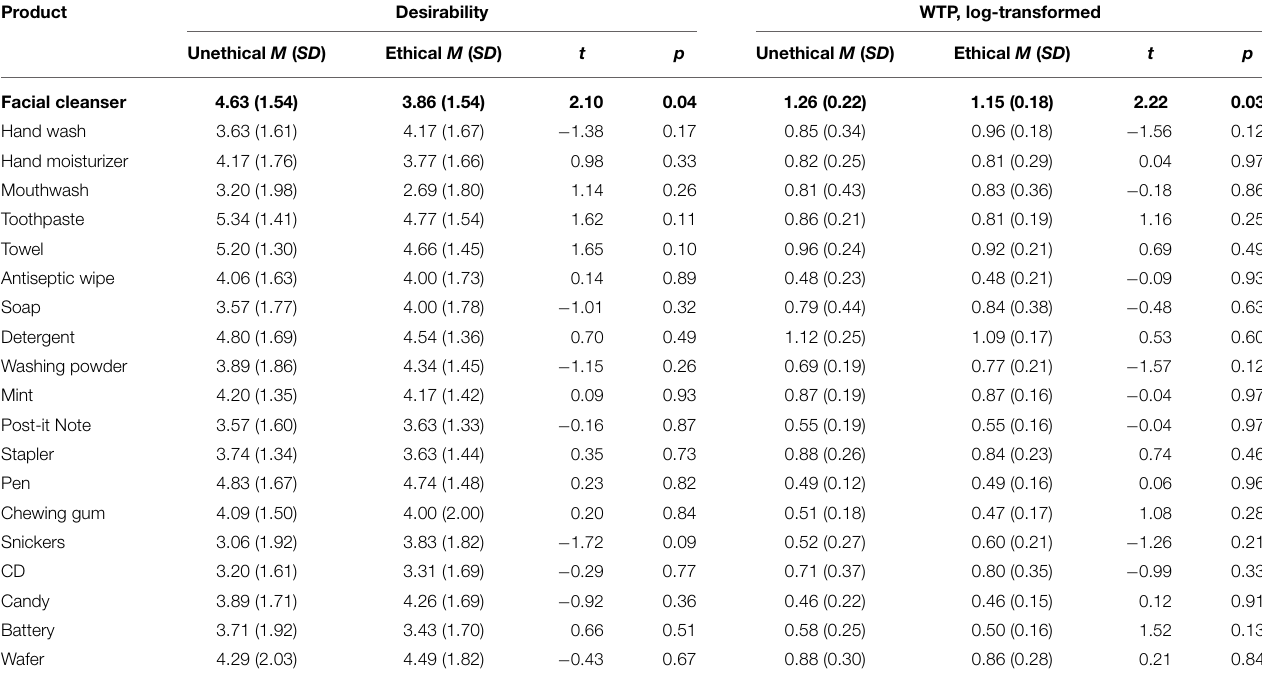
TABLE 2 | Desirability of and willingness to pay (WTP) for each product as a function of unethical vs. ethical recall in Experiment 2.